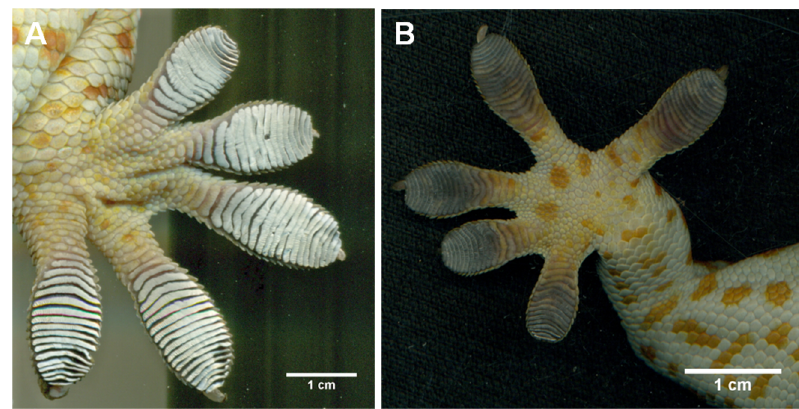
Figure 1. Wet and dry Tokay gecko ( Gekkogecko ) toe pads. (A) Dry foot in contact with a glass substrate where the setal mats appear white in color and (B) a wet foot in contact with a glass substrate where the setal mats appear grey in color. When wet the toe pads are no longer superhydrophobic and water droplets fall into the setal mat, completely wetting it.